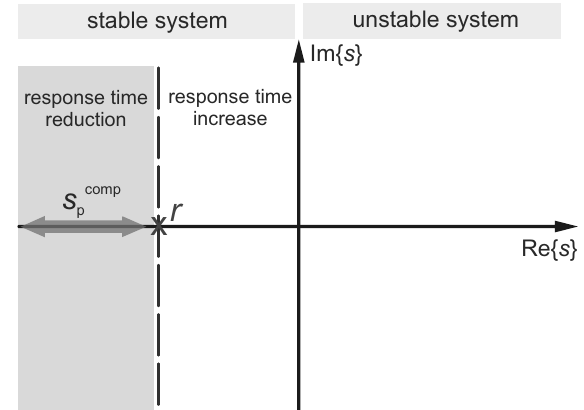
Figure 16. Representation of the complex Gauss plane exhibiting the real part r of the dominant pole s defl of the open-loop sensor p and the LOH relative to this pole (gray region). The dominant pole s comp p of the closed-loop sensor has to be located in this half plane to enable a response time reduction according to Eq.